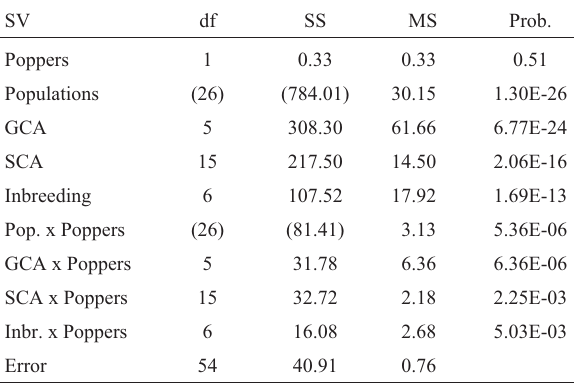
Table 1 - Joint diallel analysis of expansion volume data (mL/g) of six popcorn populations, their hybrids and selfed parents, obtained using a hot air popcorn machine and the CNPMS/Embrapa popcorn machine.